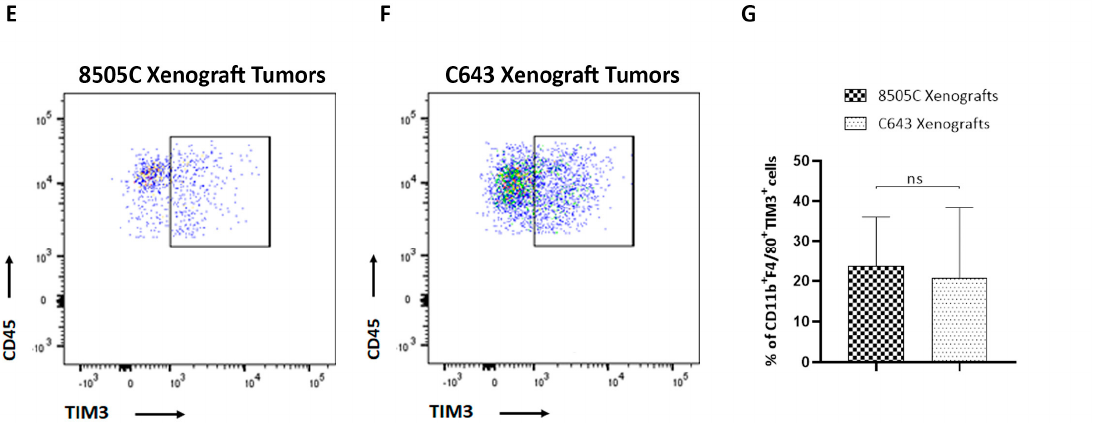
Figure 4. TIM3-positive macrophages were recruited to ATC xenograft tumors. ( A ) I. Upper panel: TIM3 mRNA expression in RAW264.7 cells and in ATC xenografts. Total RNA was isolated, and the mRNA expression of TIM3 was examined by RT-PCR analysis. Lane 1, RAW264.7 cells; lanes 2–4, 8505C xenograft tumors ( n = 3); lanes 5–7, C643 xenograft tumors ( n = 3). The lower panel represents the expression of actin. II. TIM3 mRNA expression was normalized by β -actin. Densitometry anal- ysis of TIM3 is shown. Representative results of 3 independent experiments. ( B – D ) 20X and 63X images of 5 μ m thick 8505C xenograft tumor sections immunostained with TIM3-PE antibody (red). Nuclei were counterstained with DAPI. Representative immunofluorescence images of 3 independ-